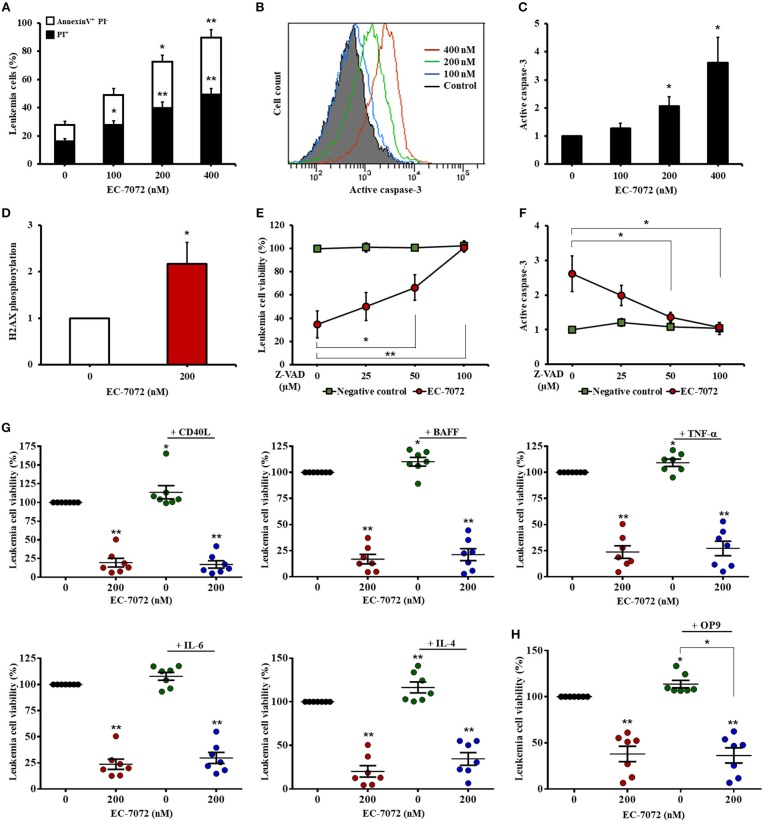
EC-7072 induces caspase-dependent apoptosis on primary CLL cells. (A) Apoptosis of leukemia cells was evaluated by cytofluorometric assessment of Annexin V/PI staining in PBMCs from patients with CLL (n = 6) treated with EC-7072 (0–400 nM) for 24 h. Bars represent the percentages of apoptotic [Annexin V+ PI−] and dead [PI+] cells. (B,C) Levels of active caspase-3 in leukemia cells were assessed by flow cytometry in PBMCs from patients with CLL (n = 6) treated with EC-7072 (0–400 nM) for 24 h. Histograms illustrate the MFI of a representative patient (B). Bars depict the MFI normalized to the control (DMSO) condition (C). (D) Levels of phosphorylated H2AX were assessed by phosphoflow in isolated leukemia cells from patients with CLL (n = 4) treated with 200 nM EC-7072 for 12 h. Bars depict the MFI normalized to the control (DMSO) condition. (E,F) PBMCs from patients with CLL (n = 6) were pretreated with increasing doses of Z-VAD-fmk (0–100 μM) followed by exposure to EC-7072 (200 nM) for 24 h. (E) Viability of leukemia cells was evaluated by DiOC6(3)/PI staining. The graph depicts the percentage of viable [DiOC6(3)+] cells normalized to the control (DMSO) condition. (F) Levels of active caspase-3 were examined by flow cytometry in leukemia cells. The graph depicts the MFI normalized to the control (DMSO) condition. (G) PBMCs from patients with CLL (n = 7) were incubated with 200 nM EC-7072 in combination with 100 ng/mL CD40L, 50 ng/ml BAFF, 40 ng/mL TNF-α, 40 ng/mL IL-6 or 40 ng/mL IL-4 for 24 h. Leukemia cell viability was assessed by DiOC6(3)/PI staining. Graphs depict the mean percentage of viable [DiOC6(3)+] cells normalized to their respective control (DMSO) condition for each individual experiment. (H) PBMCs from patients with CLL (n = 7) were co-cultured with OP9 cells for 72 h and were exposed to 200 nM EC-7072 for the last 24 h. Viability of leukemia cells was evaluated by DiOC6(3)/PI staining. Graphs depict the percentage of viable [DiOC6(3)+] cells normalized to their respective control (DMSO) condition for each individual patient. (Mean ± SEM) (*P < 0.05; **P < 0.01; Student's t-test).